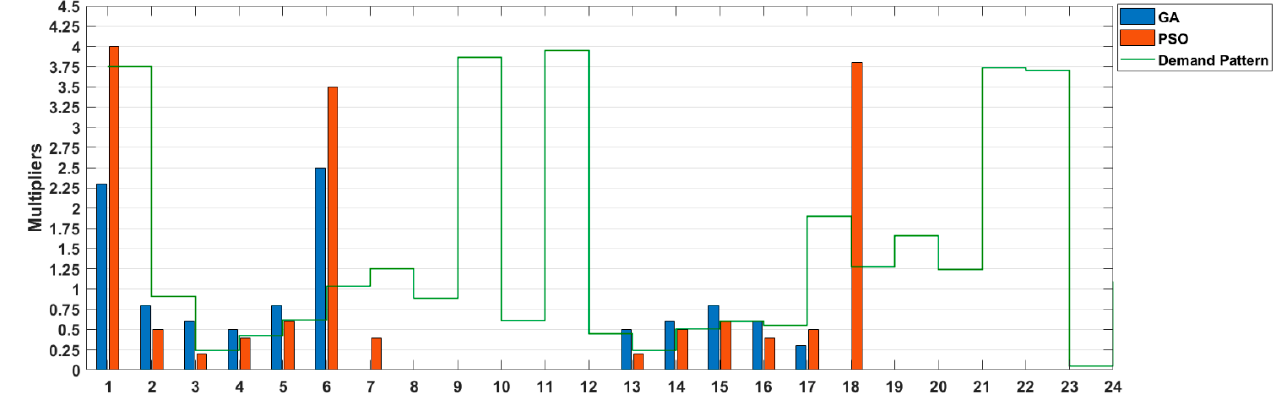
Figure 7. Node 1 CBS pattern chlorine injection from GA vs. PSO.